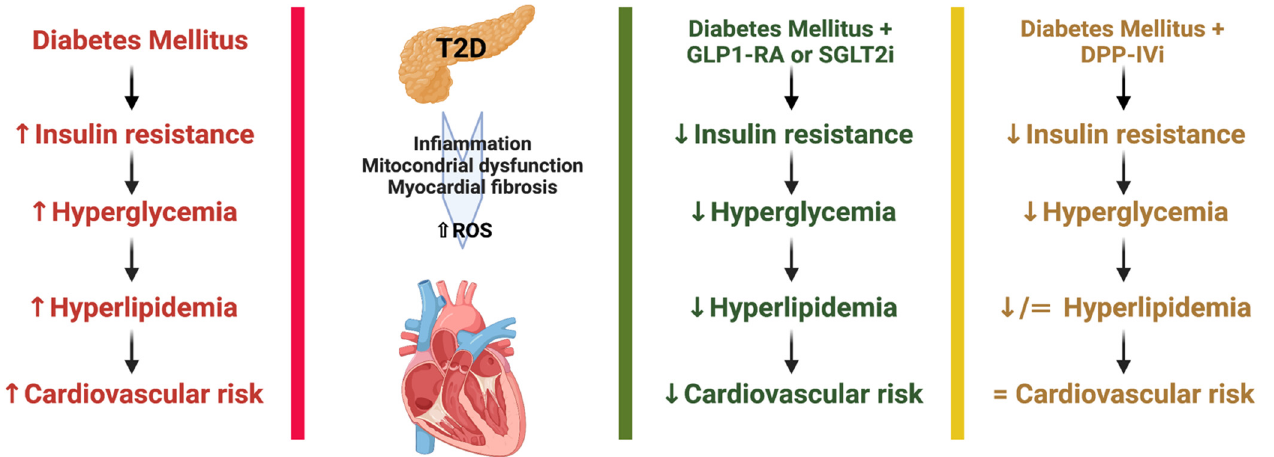
Figure 1. Recent pharmacological options for Type 2 Diabetes and efficacy at cardiovascular risk: from the data presented, we can affirm that GLP1-RA and SGLT2i have demonstrated, regarding the duration of the studies, the inclusion of subjects with diabetes, and the primary outcome vs. control group demonstrated more efficacy to reduce cardiovascular risk, ( ↑ : increased, ↓ :